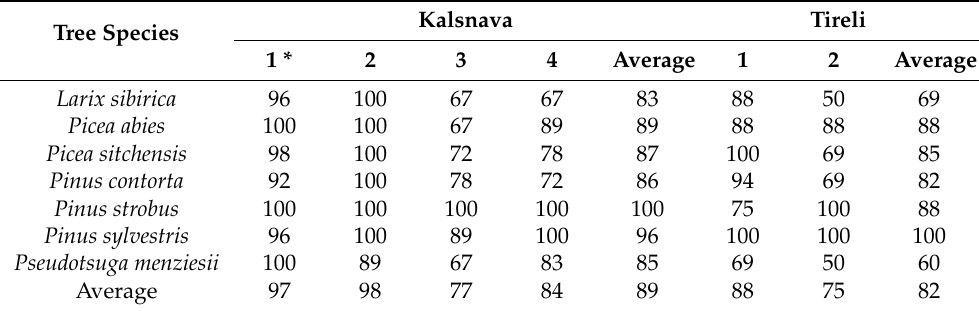
Table 3. The Heterobasidion annosum s.l. infection frequency (%) of wood discs of different tree species in the Kalsnava and Tireli study